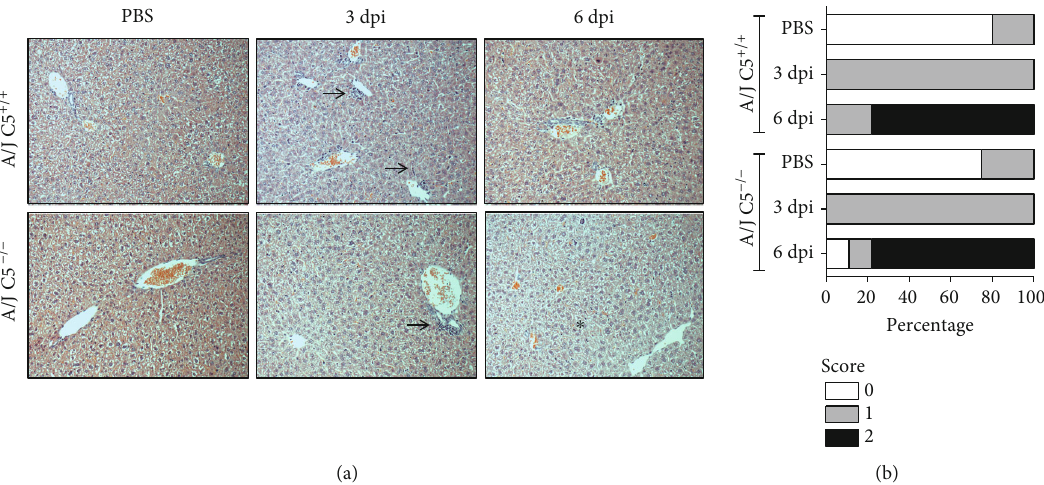
Figure 1: Liver histopathological analysis in LPF-infected A/J mice. Mice were inoculated i/p with 1 : 5 × 10 8 LPF or only PBS and then euthanized on the third or the sixth days postinfection ( n ≥ 4 ). (a) Liver sections (3 – 5 μ m) were stained with HE and evaluated at 200x magni fi cation. Arrows indicate leukocyte in fi ltration in the portal space and in the hepatic sinusoids. Asterisk indicates mitotic cells. (b) Total scores of hepatic lesions. A/J -/- : C5-de fi cient mice, PBS ( n = 5 ), 3dpi ( n = 12 ), 6dpi ( n = 9 ); A/J C5 +/+ : congenic C5-su ffi cient mice PBS ( n = 4 ), 3dpi ( n = 10 ), 6dpi ( n = 9 ). dpi: days